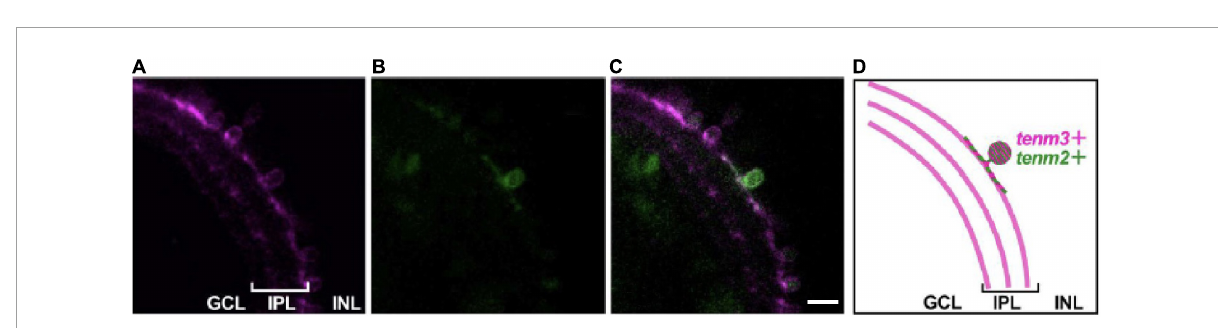
FIGURE6 Teneurins are expressed together in the same cell in vivo . Tg ( tenm3:Gal4; UAS:RFP ) zebrafish embryos were injected with a tenm2:citrine BAC construct to mosaically label Tenm2-positive cells (citrine signal, B ) in the background of all Tenm3-positive cells (RFP signal, A ). (C) Merged image to show a small-field amacrine cell expressing both Tenm2 and Tenm3. (D) Schematic of the images showing the Tenm3- (tenm3+) and Tenm2 double-positive (tenm2+) amacrine cell. Scale bar, 10 µ